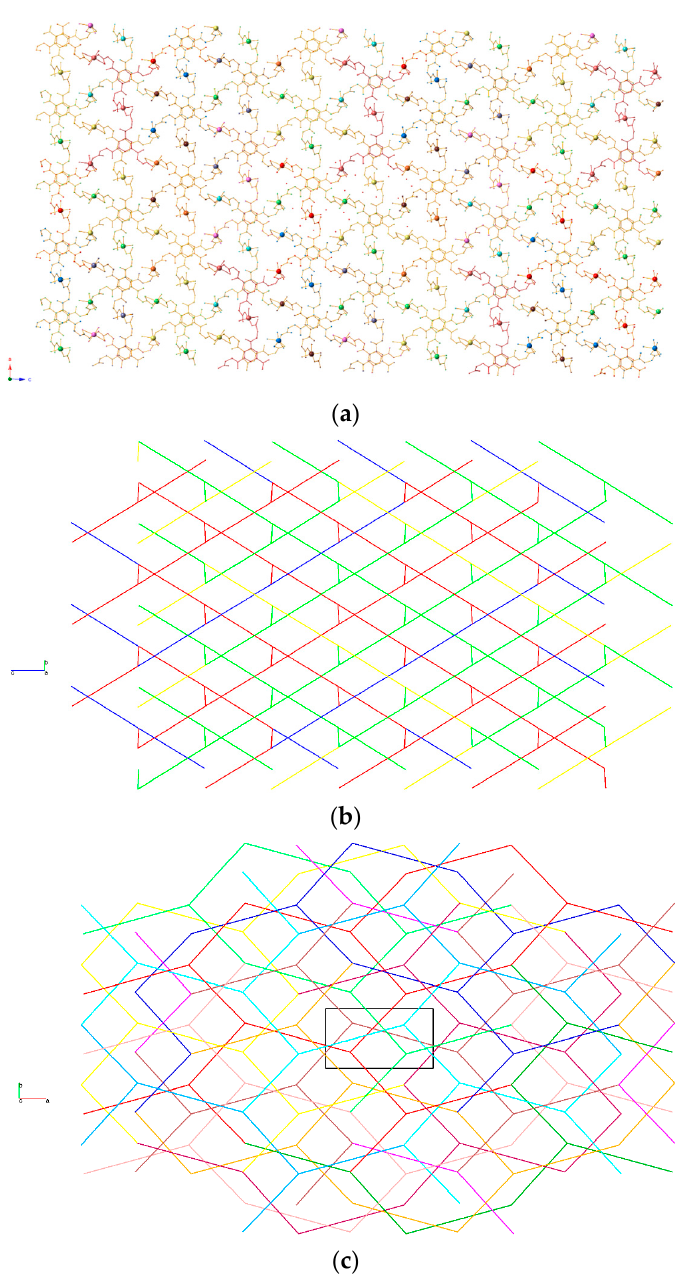
Figure 4. Simplified coloured versions of the 3D 12-fold interpenetrated ths network found in 1 along the a0c ( a ), b0c ( b ), b0a ( c ) planes.